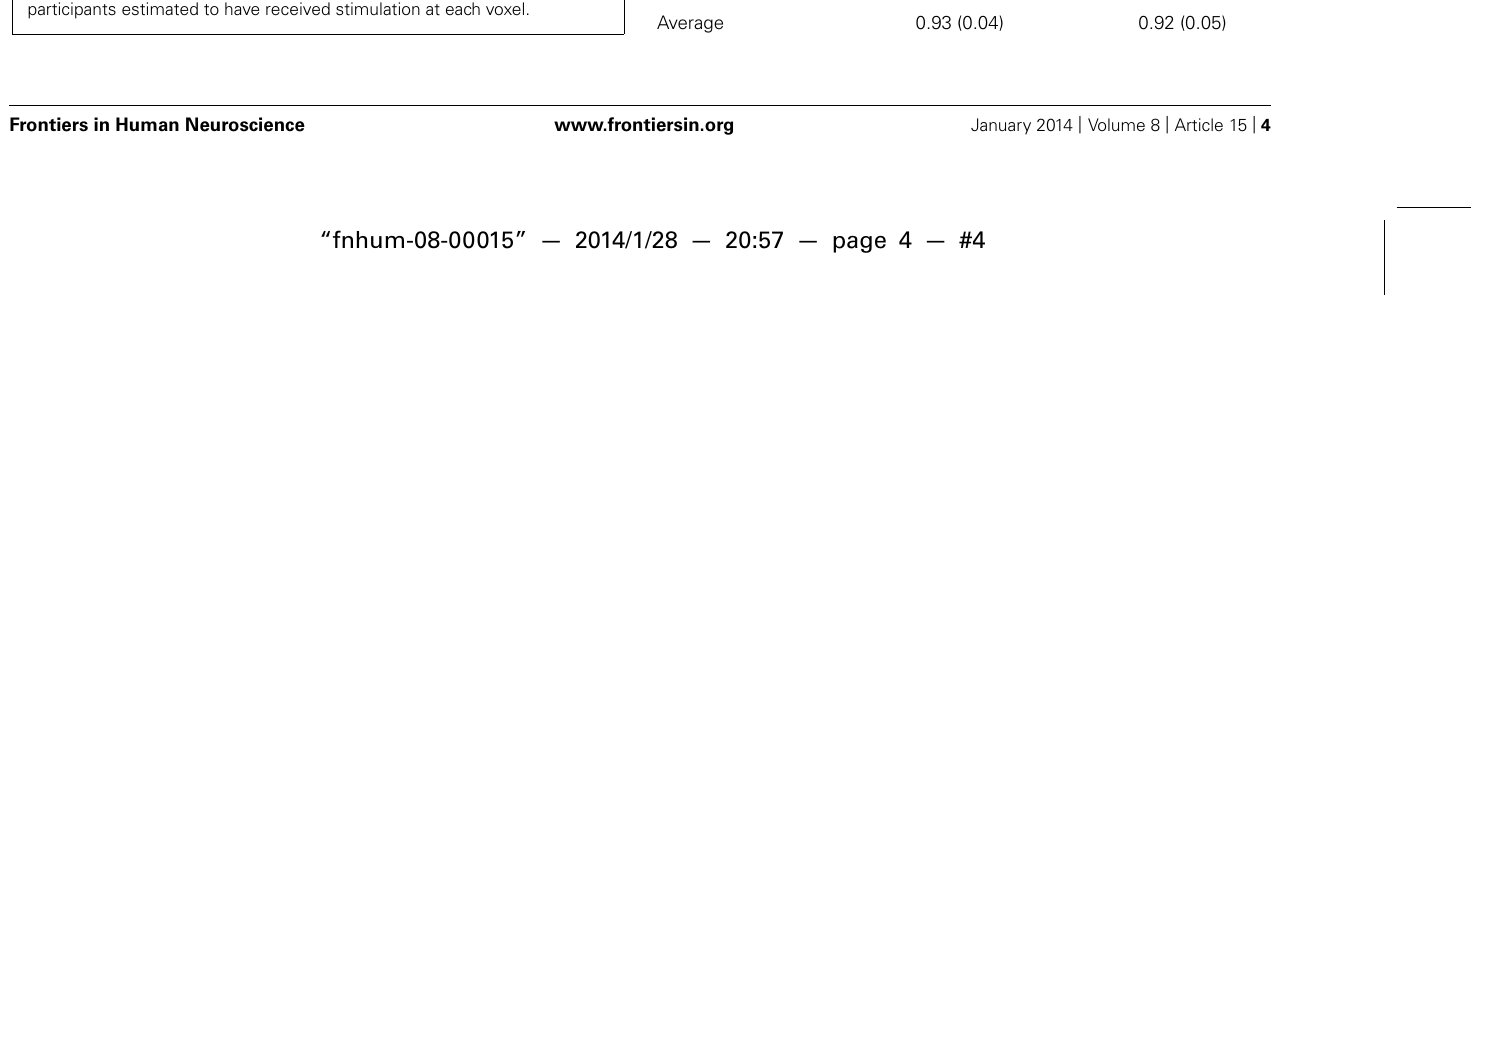
FIGURE 2 | Distribution of rTMS sites and estimated spread of rTMS effects, displayed as a topographical histogram on a representative brain in standardized space. The color scale indicates the number of participants estimated to have received stimulation at each voxel.